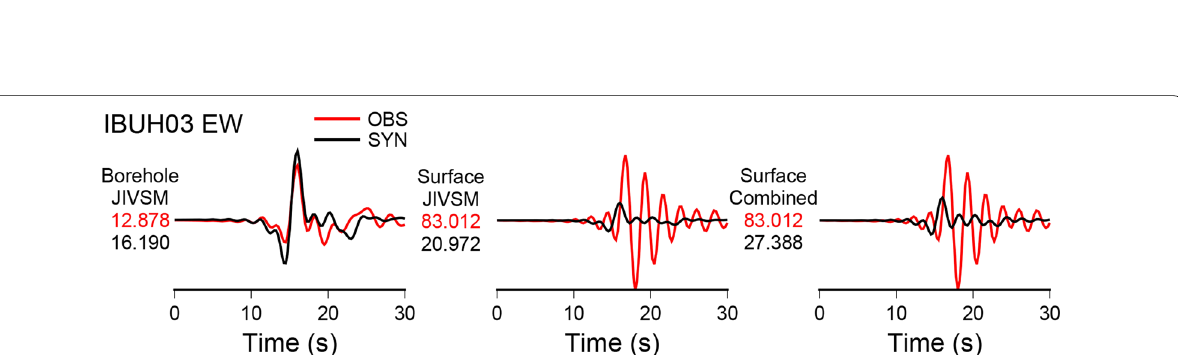
Fig. 5 Observed and synthetic borehole and ground surface waveforms of EW components at station IBUH03. Locations, velocity structure models for calculating synthetic waveforms, and maximum amplitudes of the observed (red) and synthetic (black) waveforms are shown to the left of each